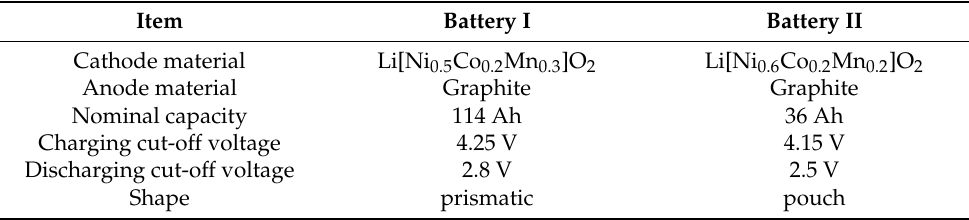
Table 1. Nominal specifications of the batteries.